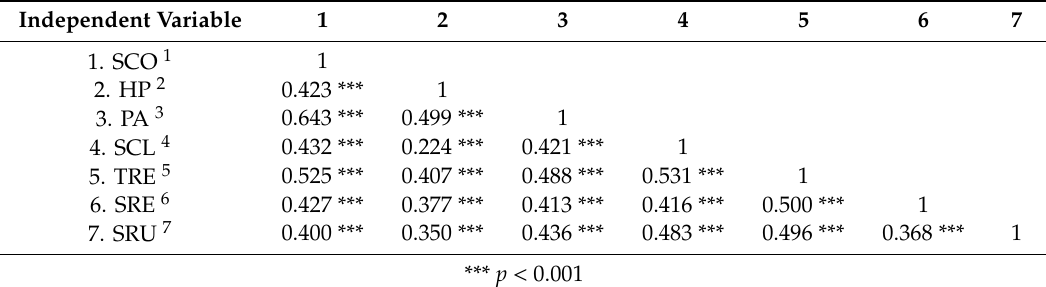
Table 5. Comparison of Means between Physical Self-Content and School Adjustment. Independent